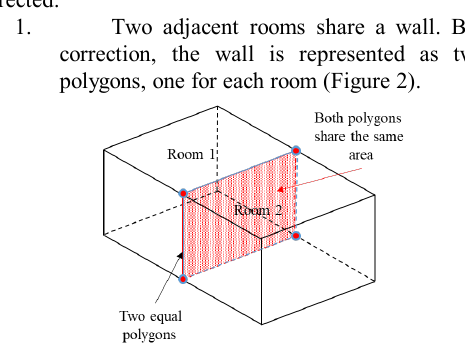
Figure 2. Case 1: Both rooms share equal polygons. 2. Two adjacent rooms share a portion of the division wall and one of its vertical edges. Both polygons have two vertexes (an edge) and a part of its area in common (Figure 3.)